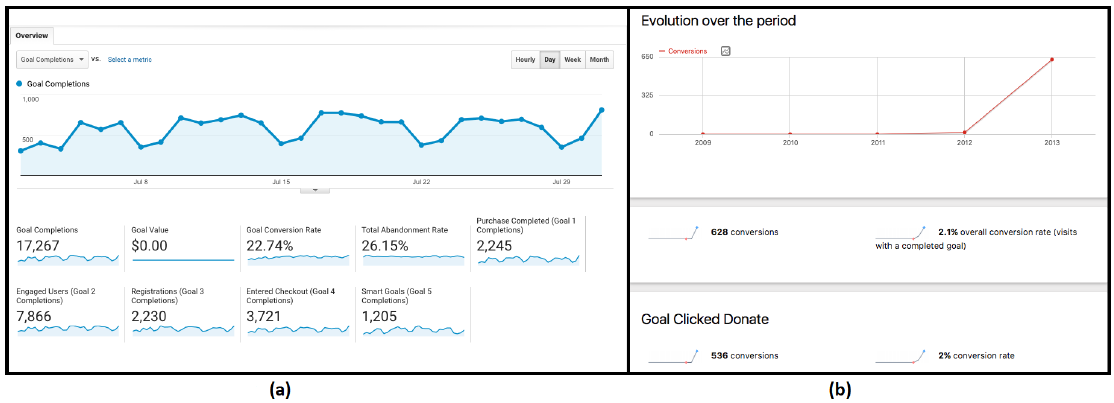
Figure 1. Goal reports by Google Analytics ( a ) and Matomo ( b ), typically used to display the performance of user pre-defined goals such as number of sign-ups and purchases through